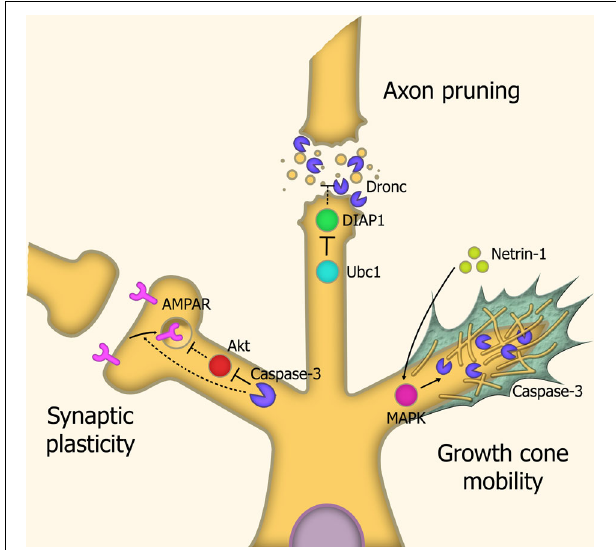
FIGURE 4 | Caspases in neuronal restructuring and signaling. Synaptic plasticity : Through cleavage of Akt, caspase-3 is involved in the endocytosis of AMPA receptors, leading to Long-Term Depression (LTD) of synaptic signaling. Axonal pruning: Localized proteosomal degradation of Inhibitor of Apoptosis proteins (IAPs) within axons lead to a localized caspase activity which shears the axon from the cell body. This process does not kill the parent neuron. Growth cone mobility: Netrin-1 acts as a chemoattractant, signaling MAP Kinase-mediated activation of caspase-3, which remodels the cytoskeletal structure within the growth cone, allowing axonal migration down the chemotrophic gradient. Abbreviations: AMPAR, AMPA receptor; Ubc1, Ubiquitin-conjugating enzyme E2 1; DIAP1, Drosophila Inhibitor of Apoptosis 1; MAPK, Mitogen-activated protein